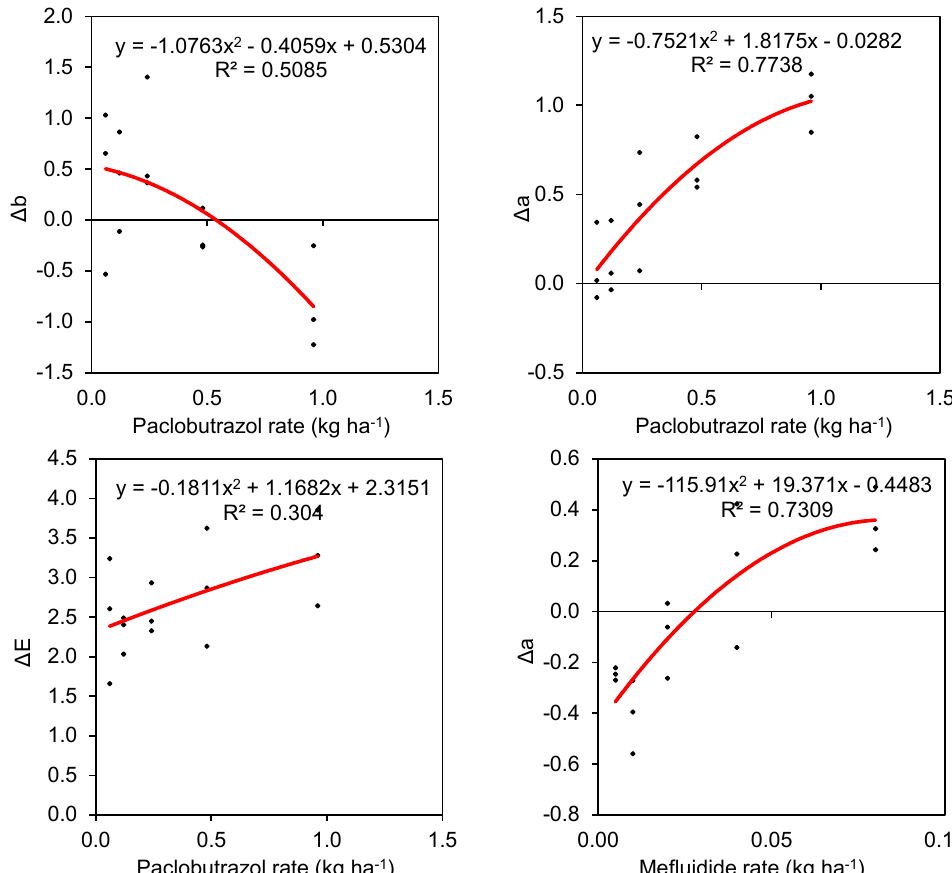
Figure 3. The non-linear regression models for the relationship between PGR rates and color parameters of leaves of Kentucky bluegrass.